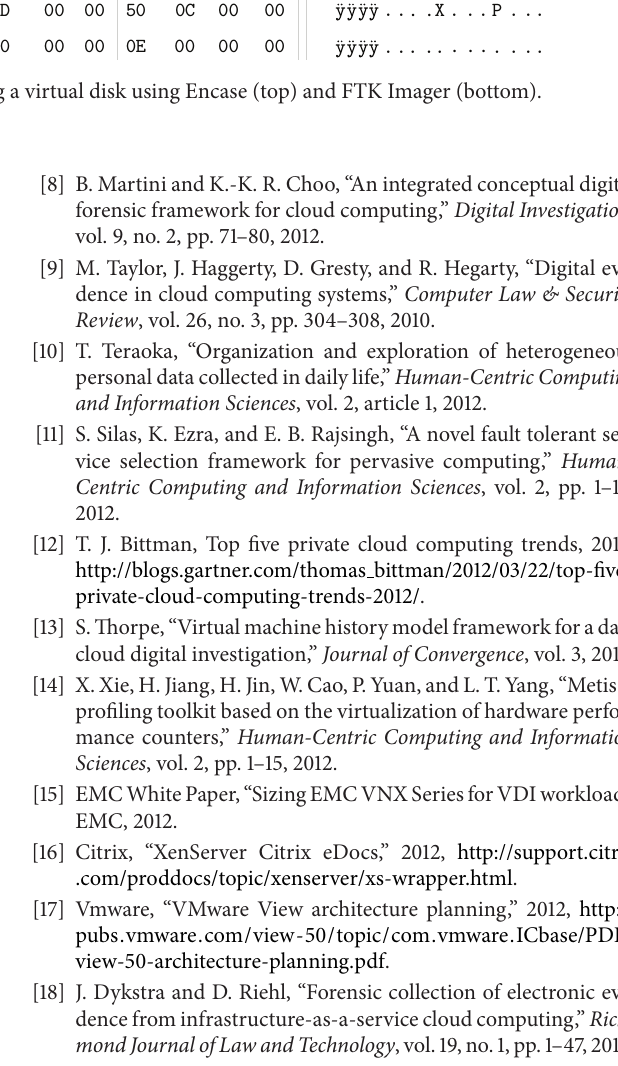
Figure 5: Image of pagefile.sys hex values while mounting a virtual disk using Encase (top) and FTK Imager (bottom).